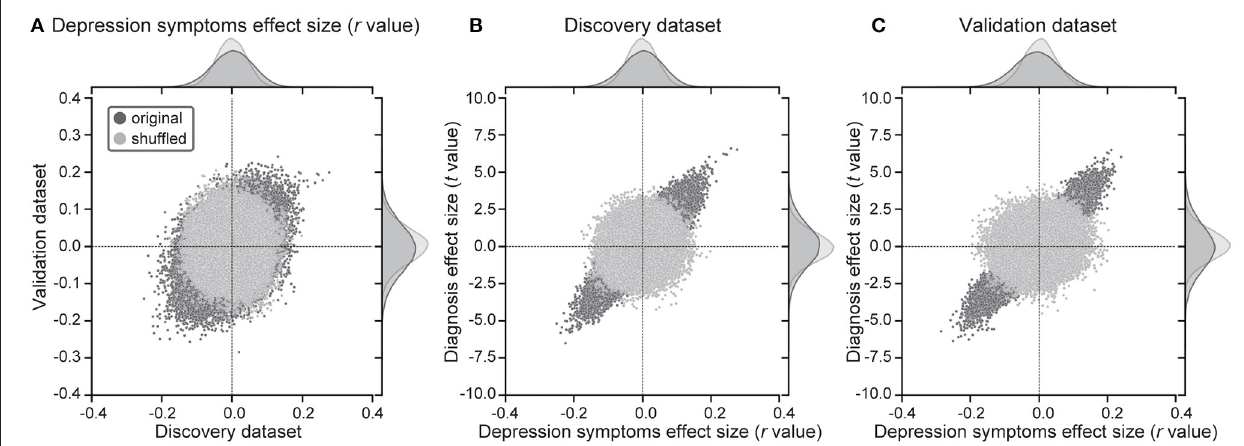
FIGURE 1 | Results of mass univariate analysis. (A) Reproducibility across the 2 datasets regarding symptom effects. Scatter plots and histograms of depression symptom effect sizes (Pearson’s correlation between BDI-II and functional connectivity strength: r -value). Each point in the scatter plots represents the symptom effect in the discovery dataset in the abscissa and that for the validation dataset in the ordinate for each functional connectivity. Original data are in black, while shuffled data in which subject information was permuted are in gray. (B,C) Shared information between diagnosis and symptom effects in both datasets. Scatter plots and histograms of diagnosis effect sizes (the difference in mean functional connectivity strengths between patients with depression and healthy groups: t -value) in the ordinate and depression symptom effect sizes ( r -value) in the abscissa for all functional connectivity in the discovery dataset (B) and the validation dataset (C) . Original data are in black, while shuffled data in which subject information was permuted are in